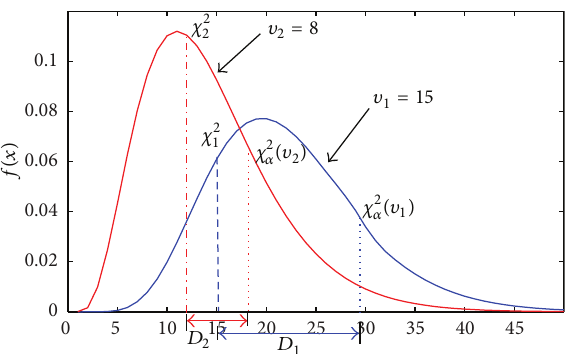
Figure 1: Comparison of 𝜒 2 distribution with different degrees of